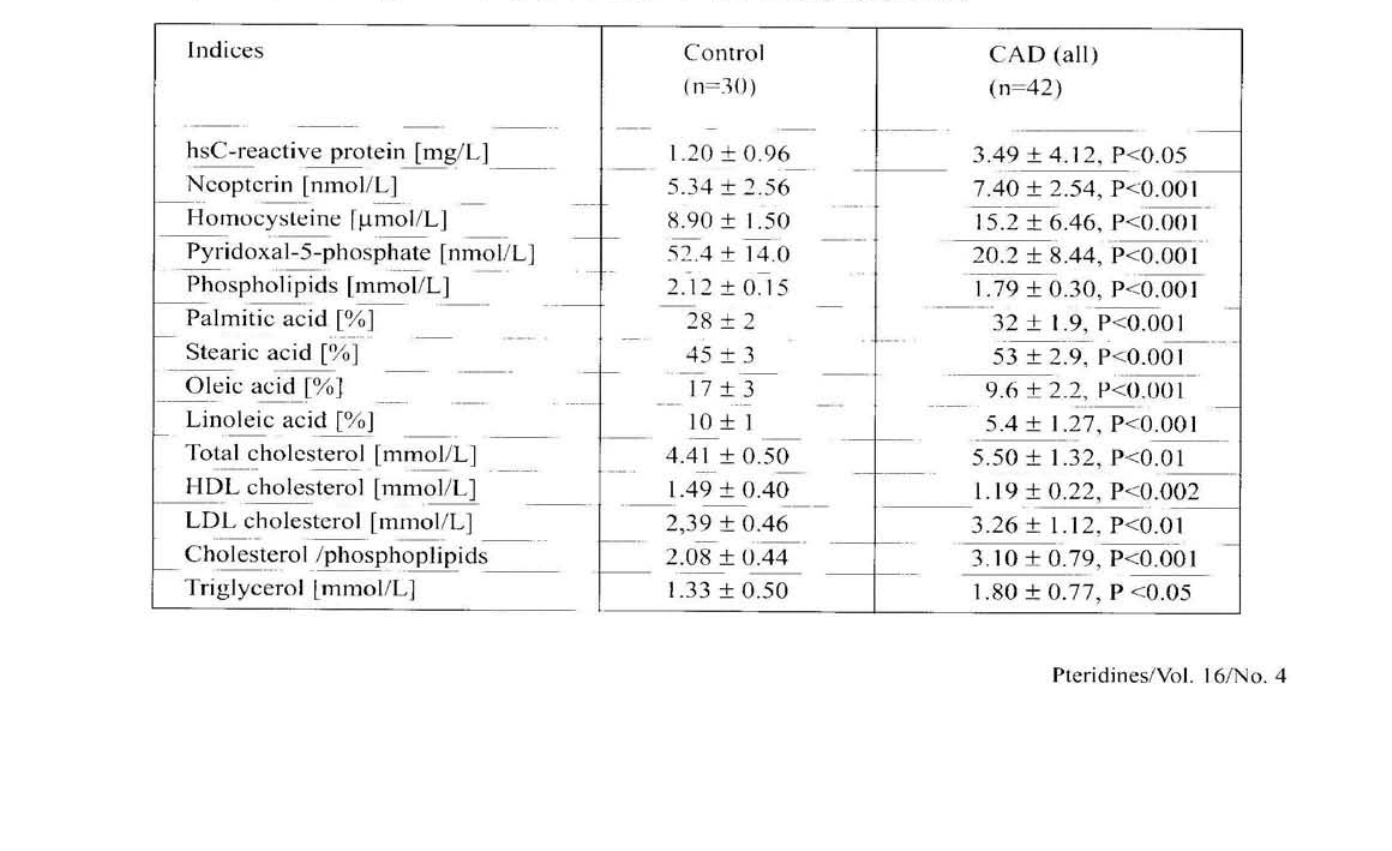
Table 1. Indices of inflammation and other risk factors in healthy individuals and in patients with coronary artery disease (CAD) before percutaneus transluminal coronary angioplasty (hsC-reactive protein - high